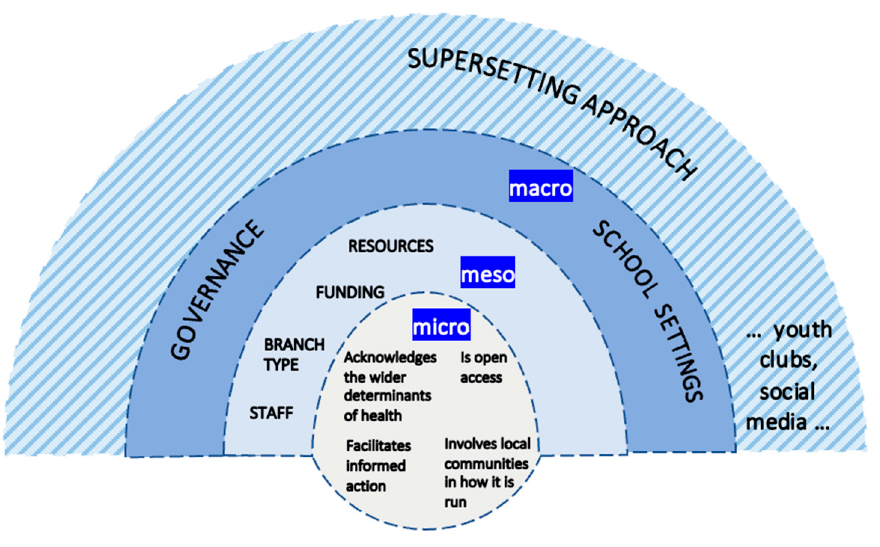
Figure 1. Conceptual model of the public library system as a supportive environment for children’s development of critical health literacy.